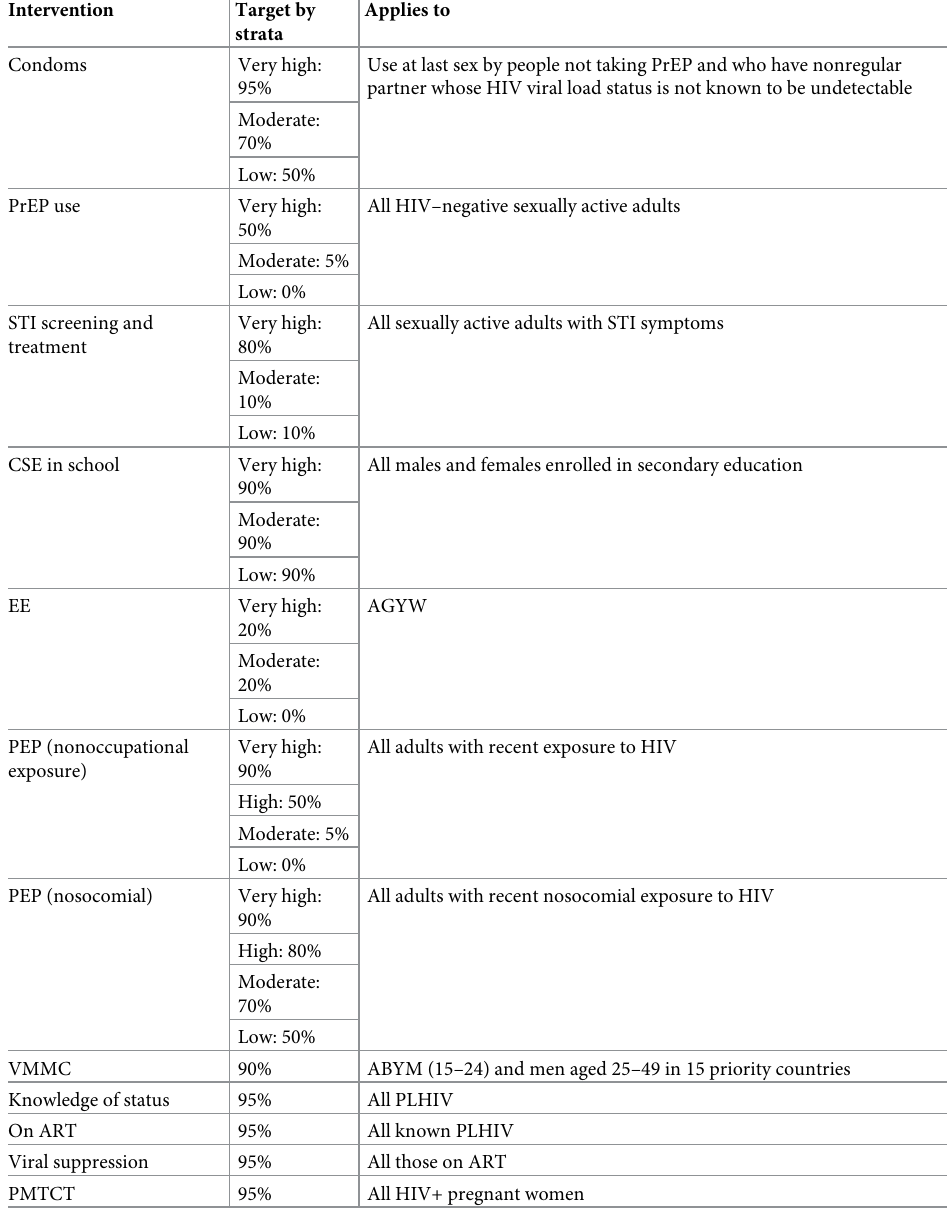
Table 4. 2025 targets for general